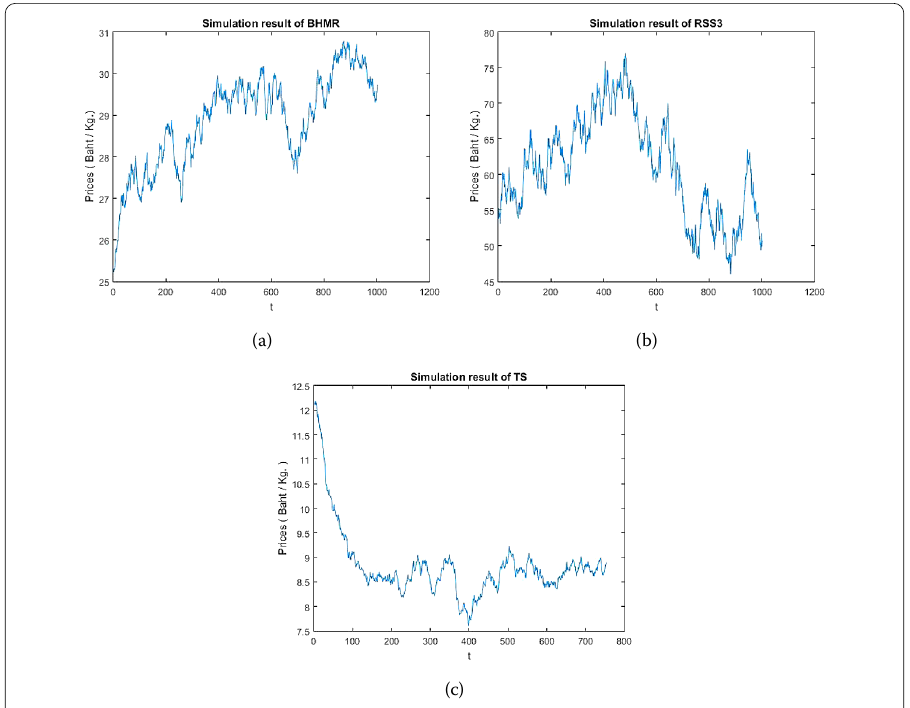
Figure 2 Results of simulation with Ornstein-Uhlenbeck process: (a) Results of simulation with Ornstein-Uhlenbeck process for BHMR. (b) Results of simulation with Ornstein-Uhlenbeck process for RSS3. (c) Results of simulation with Ornstein-Uhlenbeck process for TS.